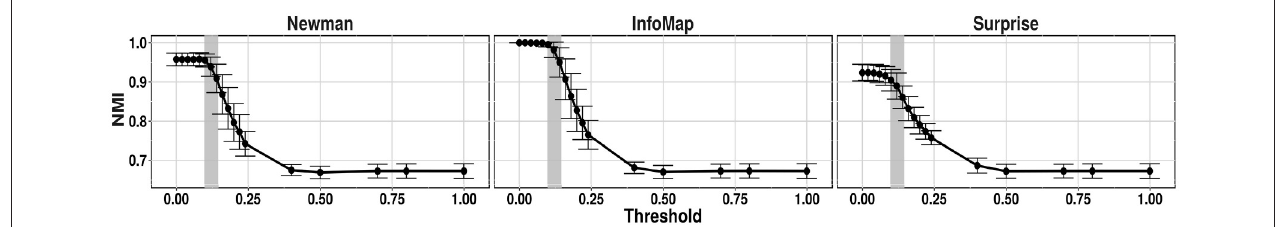
FIGURE 4 | NMI between ground truth community structure and the results of the 3 community detection algorithms applied to an LFR networks ( µ t = µ w = 0.2).